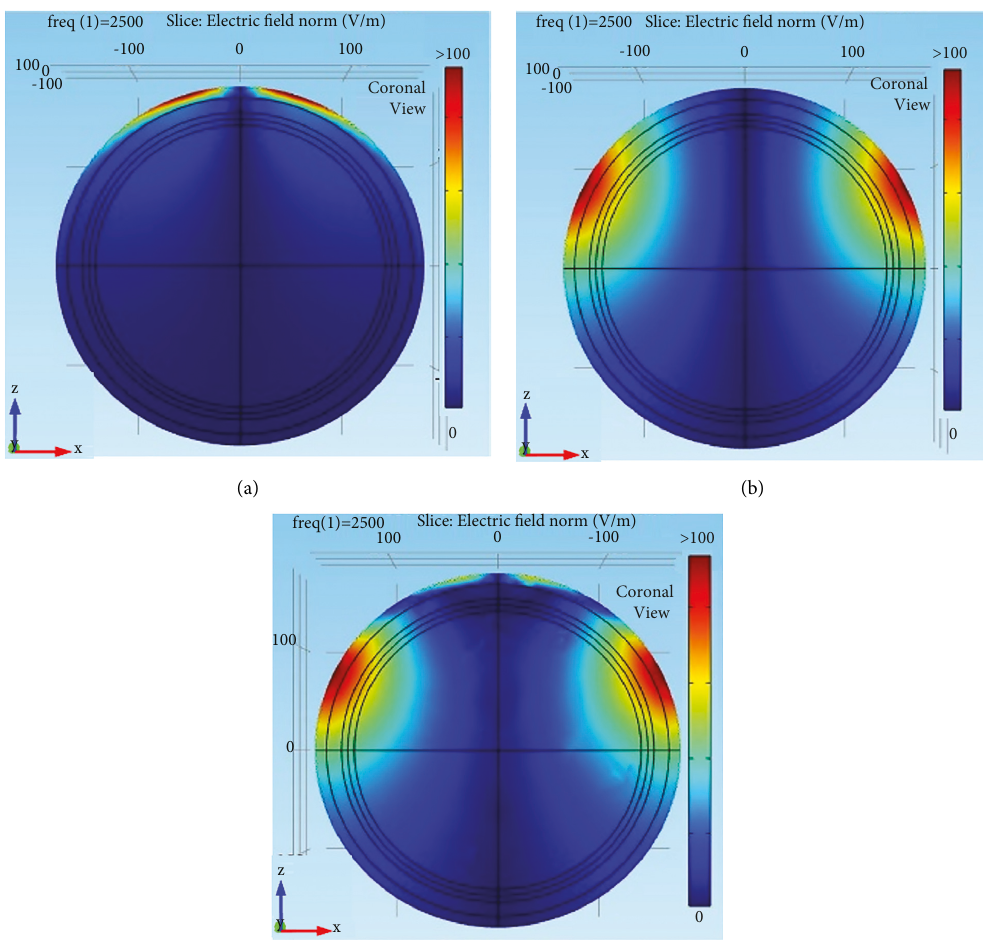
Figure 4: Electric field distribution of coils. (a) V coil, (b) Halo coil, and (c) HVA coil.